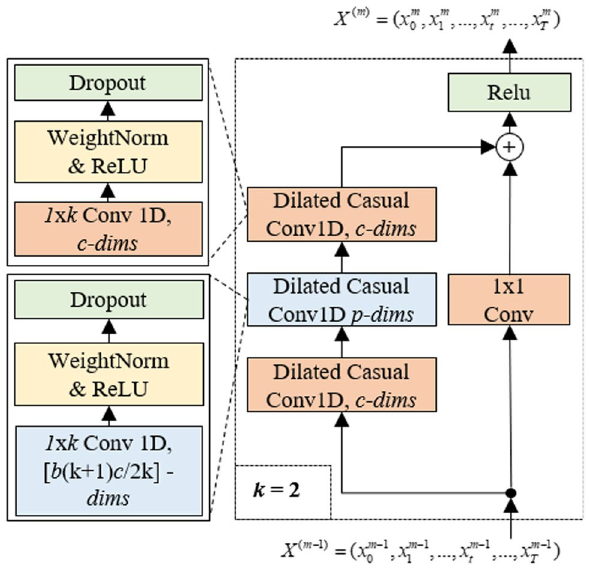
Fig. 7 The structure of the composited residual block for the TCN*